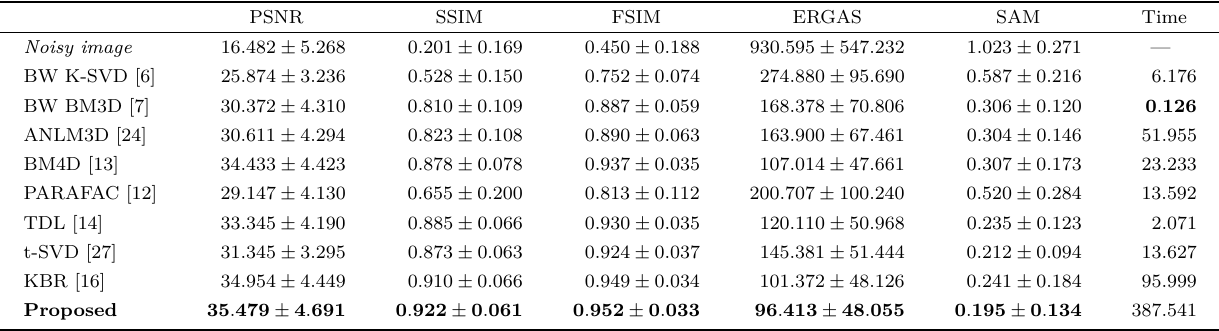
Table 1 Comparison of different denoising methods in terms of (mean ± variance) with respect to five image quality indices, and average time cost (s). Values are computed over all combinations of 32 scenes and 6 levels of noise. The best results are highlighted in